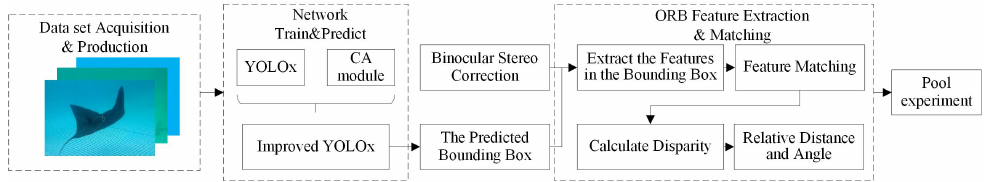
Figure 1. Flow of the visual positioning algorithm of the